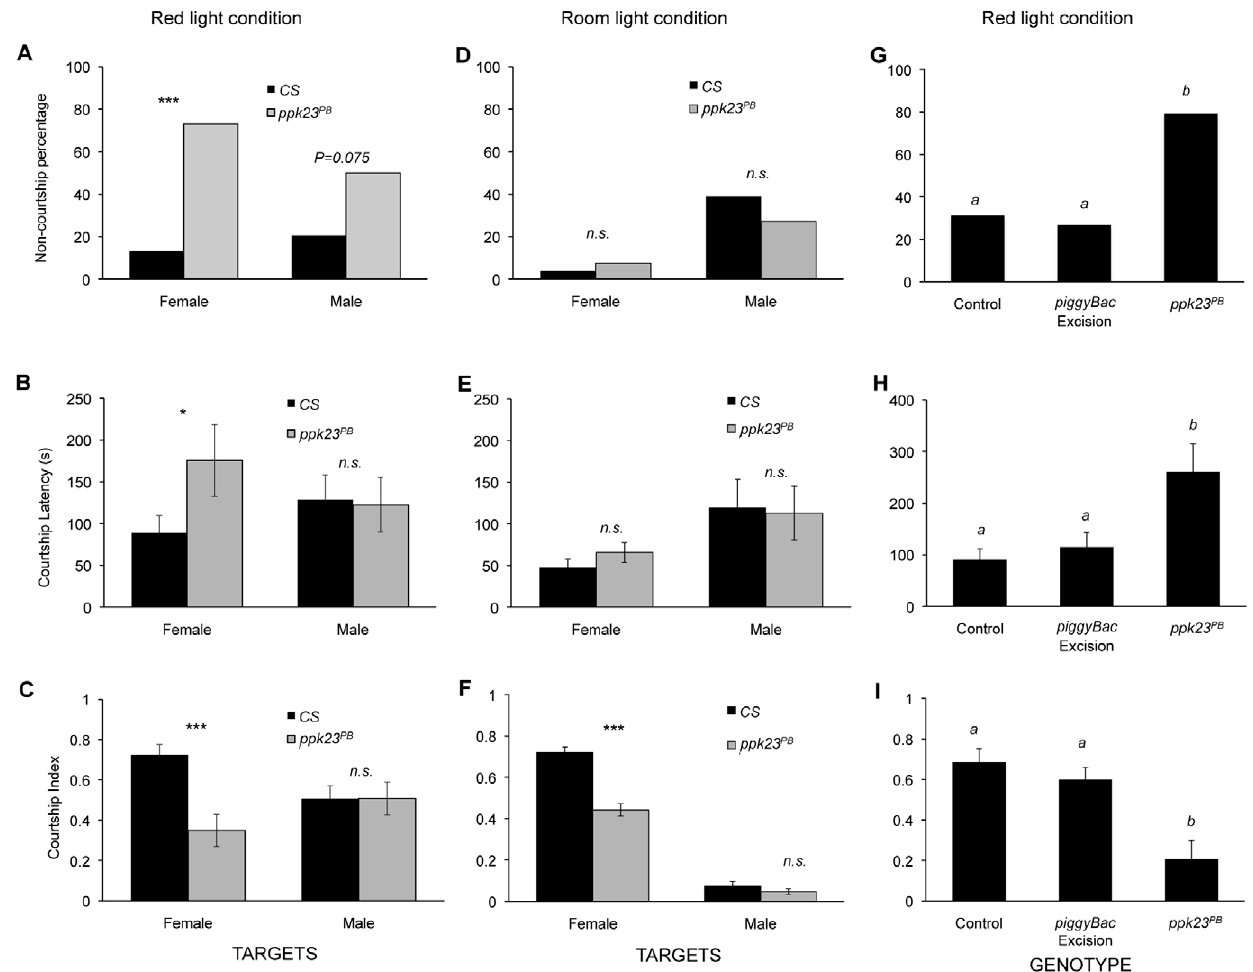
Figure 5. ppk23 is required for normal male courtship behavior. (A)Significantly higher proportion of ppk23 PB males did not show any courtship behavior in a 10-min observation time under dark (‘‘red light’’) conditions towards females ( Chi-square test ; ***, p , 0.001 ). (B) ppk23 PB males that did court showed increased courtship latency only towards females ( Two samples wilcoxon test ; *, p , 0.05 ) and (C) reduced courtship index ( Two samples wilcoxon test ; ***, p , 0.001 ). (D) Under white light conditions, proportion of courting ppk23 PB males was not different than wild types. Chi- square test , N.S. ). (E) No courtship latency differences were detected either ( Two samples wilcoxon test , N.S. ). (F) In contrast, ppk23 PB males exhibited reduced courtship index even under white light conditions ( Two samples wilcoxon test ; ***, p , 0.001 ). There were no effects of the mutation on any of the measured courtship parameters towards males under white light conditions. (G–I) piggyBac excision rescued the effect of ppk23 PB mutation on male courtship behaviors in all measured parameters under red light conditions (G; Chi-square test, p , 0.001; H; Kruskal-Wallis rank sum test, p , 0.05; I; Kruskal-Wallis rank sum test, p , 0.05 ). n=24–38 for each genotype and each condition. N.S. indicates no significant difference. Error bars denote the standard errors of the